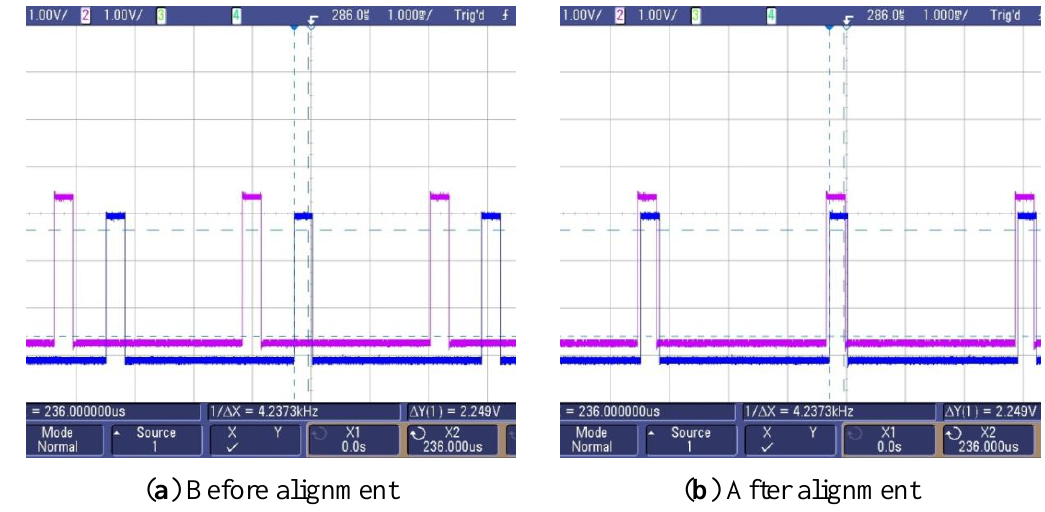
Figure 9. TAR, TACCR0 register alignment for synchronized periodic timer interrupt in two different T-Sensor